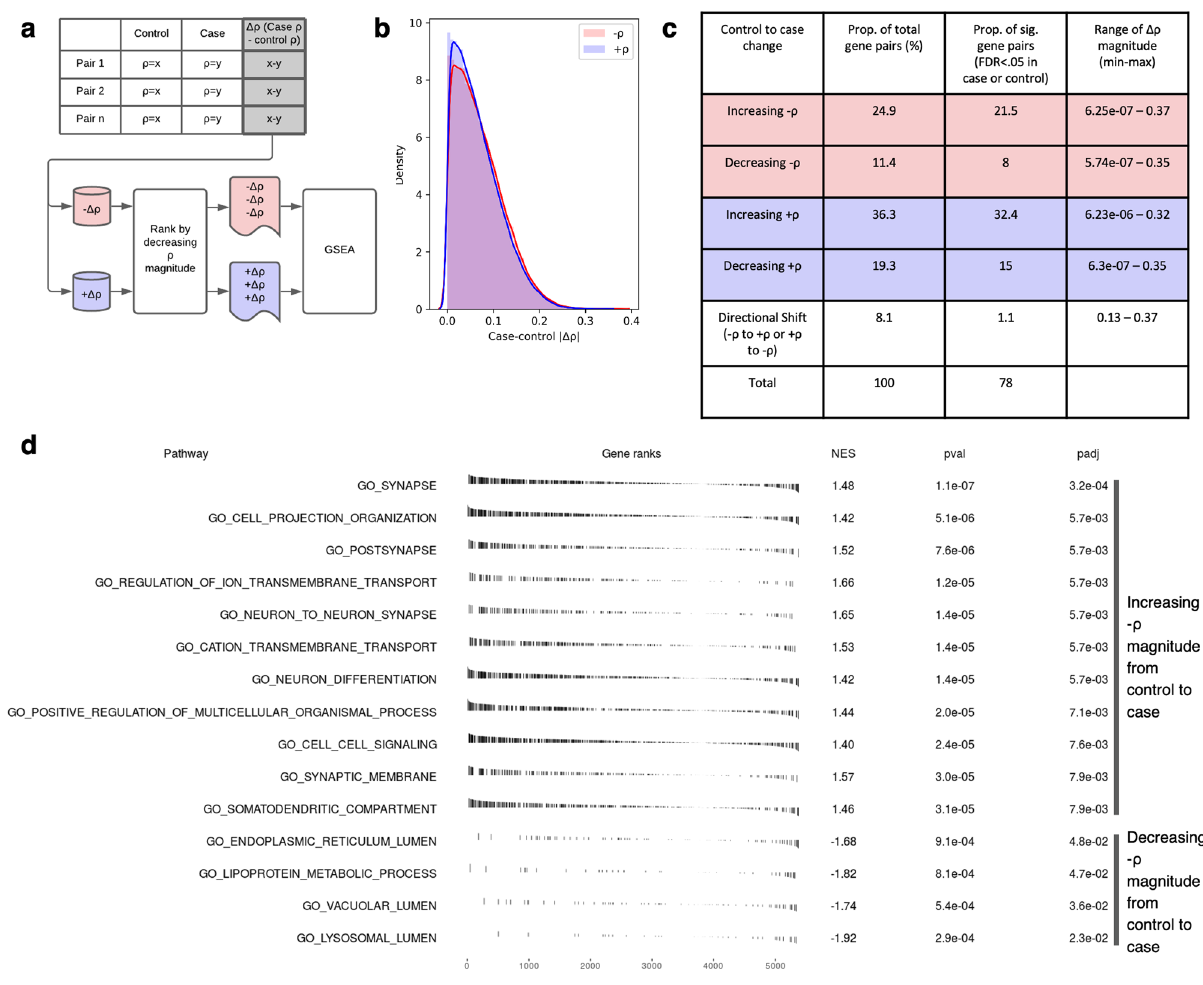
Fig. 6 ROSMAP case − control analysis of ⍴ value differences ( Δ ⍴ ). a Schematic to show generation of the case − control Δρ values, splitting of the data into positive and negative Δρ values and subsequent ranking strategy applied prior to GSEA analysis. b Density plot to show the distribution of mitochondrial − nuclear case − control Δρ in ROSMAP frontal cortex data. The red curve represents negative Δρ and the blue curve represents positive Δρ values. c Table to show the distinct groups of case − control Δρ values arising from the ROSMAP frontal cortex case − control data. d fGSEA pathway enrichments passing P < 0.05 (BH-corrected) for the negative correlation space, whereby gene pairs with − ρ have been ranked by their case − control Δρ